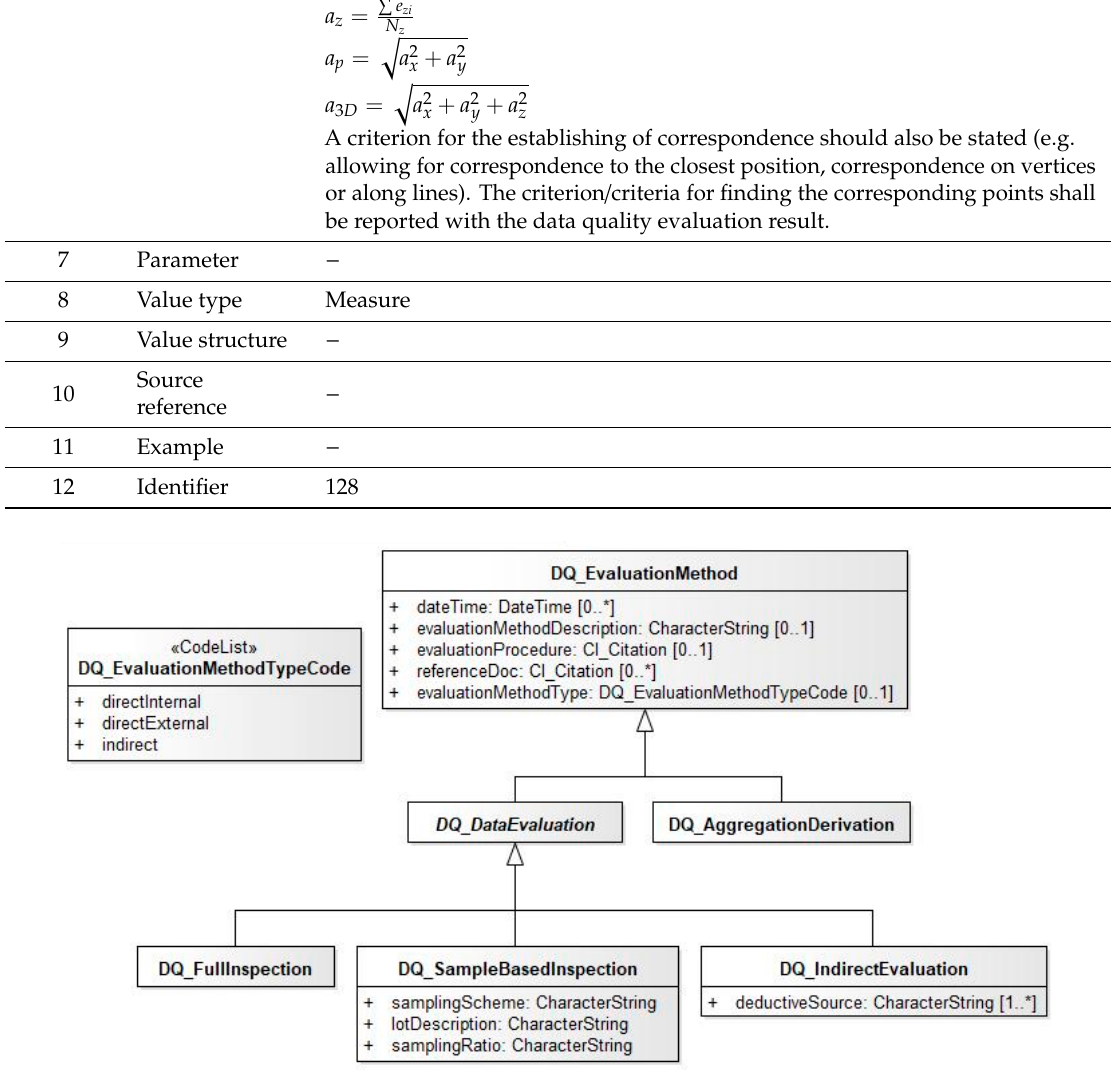
Figure 8. UML description of data quality evaluation methods.